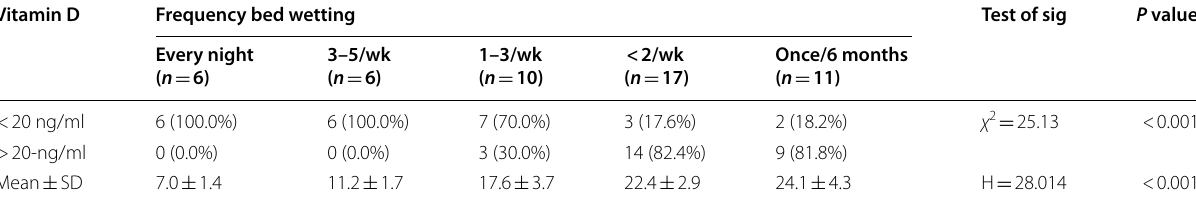
χ 2 , Chi‑square test; H, H for Kruskal–Wallis test; Pairwise comparison bet. each 2 groups was done using Post Hoc Test (Dunn’s for multiple comparisons test)